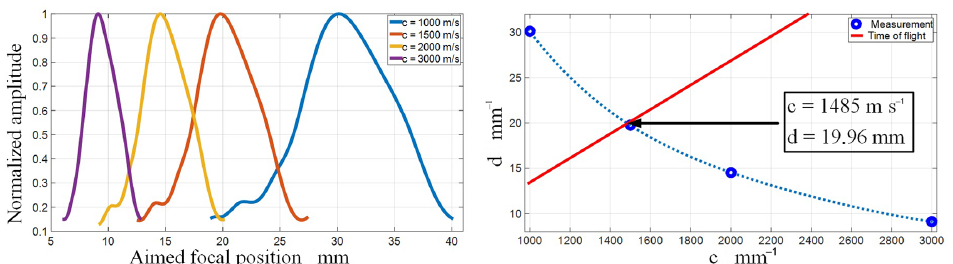
Figure 6. Left: focusing curves for different control sound velocities; right: determination of sound velocity by intersection of two curves; Red curve: reflector distance as a function of sound velocity and measured ToF. Blue curve: reflector distance as a function of the control sound velocity c control ; Blue points: four pairs of sound velocity and corresponding distance are determined by focusing